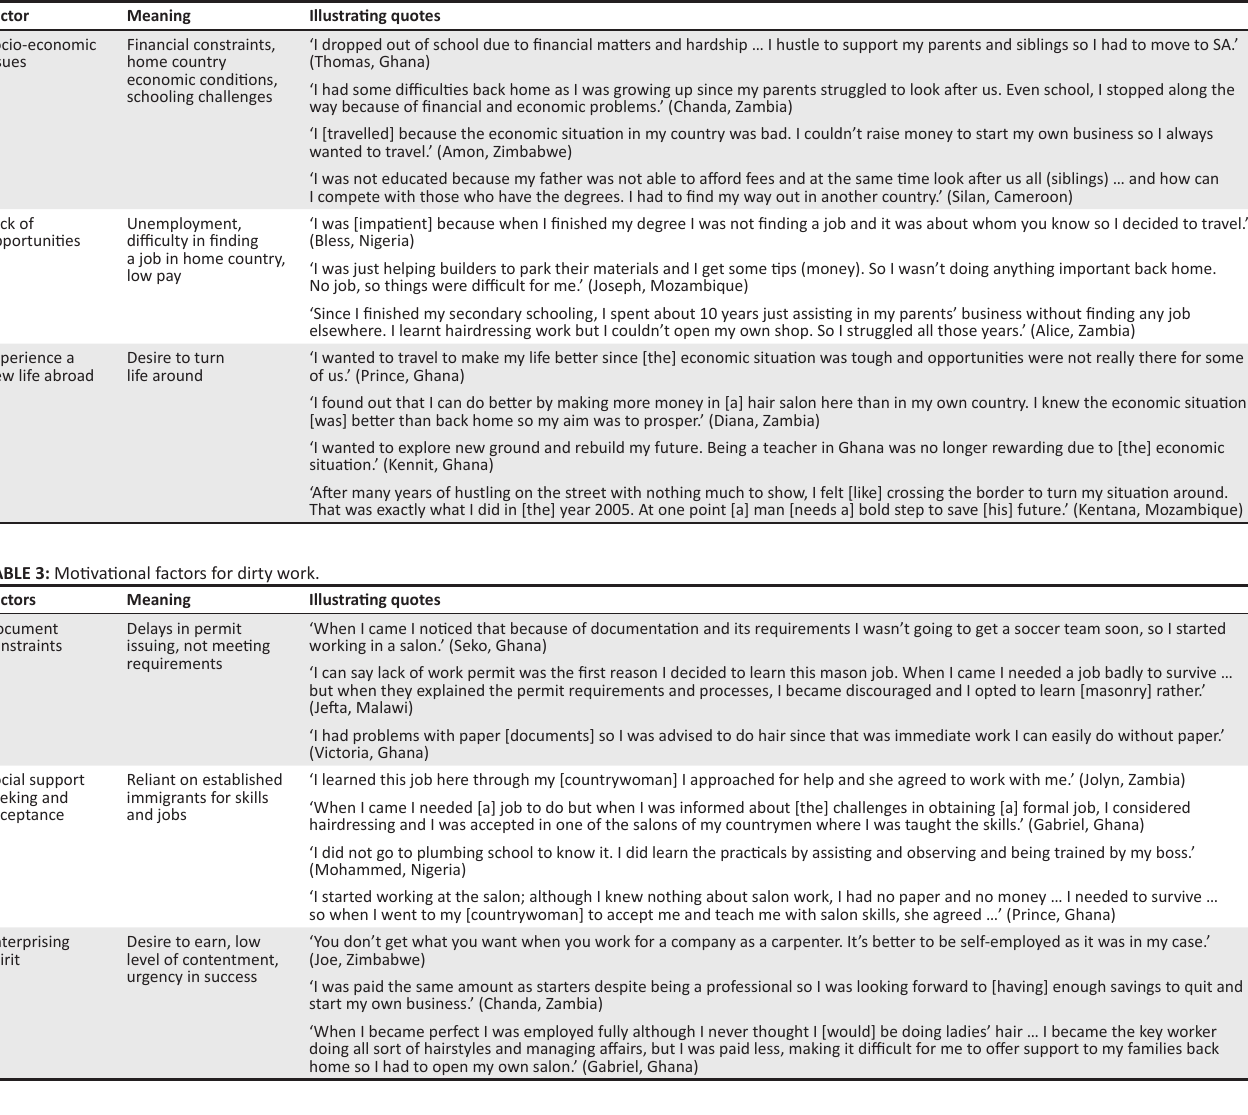
TABLE 2: Motivating factors for leaving home country. Factor Meaning Illustrating quotes Socio-economic issues